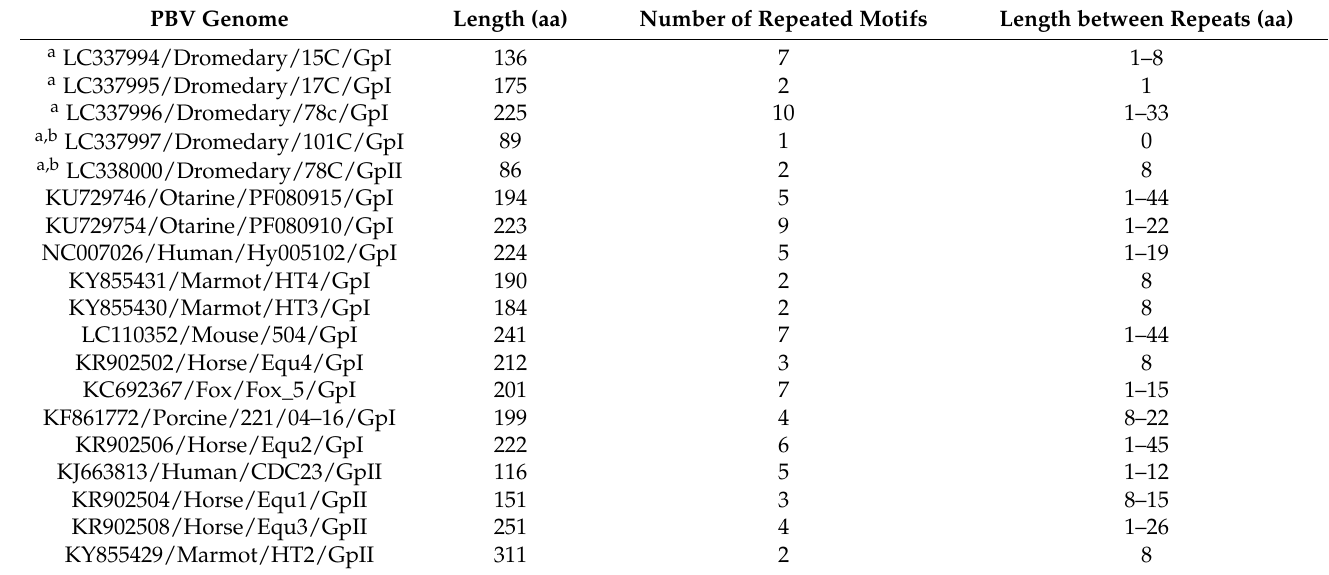
Table 3. Number of repeated ExxRxNxxxE motifs and the lengths between the repeats in segment 1 hypothetical protein sequences of genogroup I and genogroup II PBVs detected from dromedary fecal samples compared to other PBV